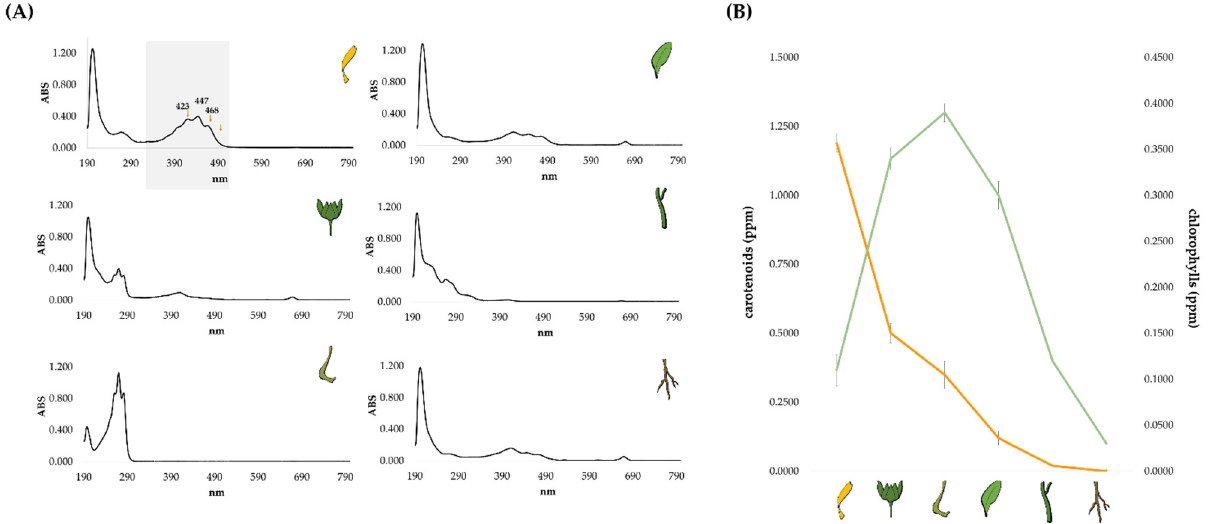
Figure 5. ( A ) UV-Vis spectra of the n -hexane extracts from the six organs of Calendula arvensis ; ( B ) relative content of chlorophylls (ppm; green line) and carotenoids (ppm; orange line) in the investigated organ extracts. Values are the mean ± SD of three independent measurements.